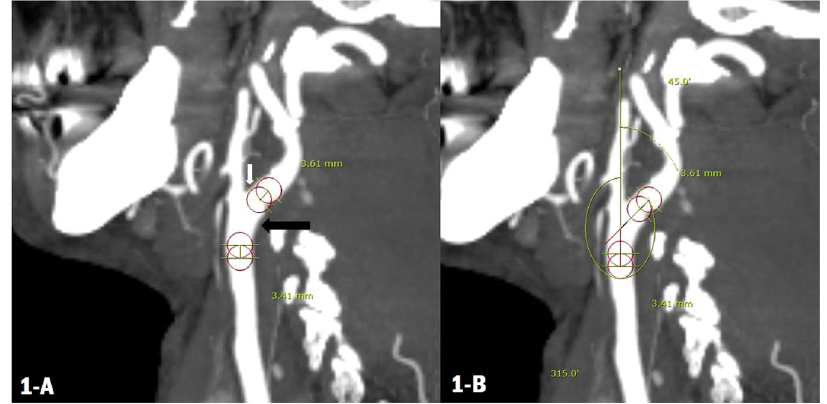
Figure 1. Methods for angle measurement of the internal carotid artery. Two straight lines, one from the common carotid artery to the head and the other from the external carotid artery to the body ( A ), were made by extending the connection of the centre of each circle ( B ). The black arrow indicates the external aspect of the bifurcation, and the white arrow indicates the internal aspect of the